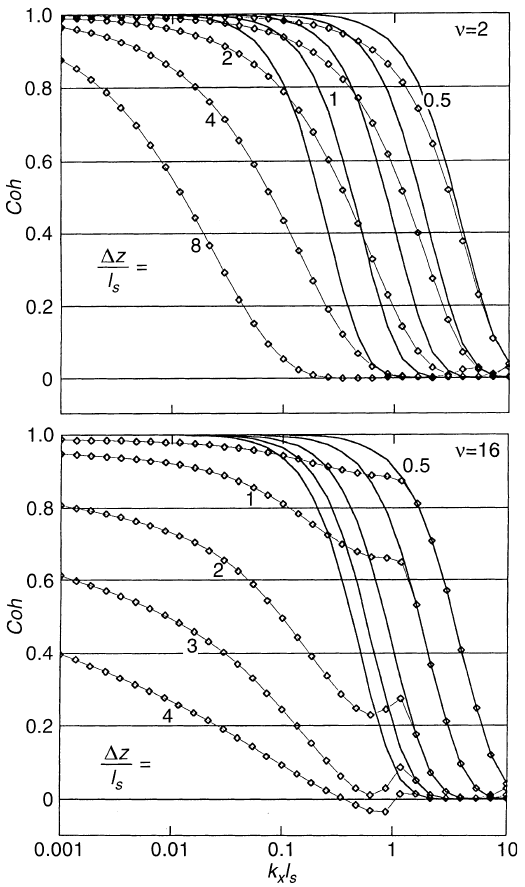
Fig. 6. The coherency spectra Coh (cid:133) k x ; (cid:68) z ; (cid:112) = 2 (cid:134) for E (cid:133) q (cid:134) (cid:136) q (cid:255) 3 and (cid:103) (cid:136) 1 (cid:135) (cid:133) ql s (cid:134) (cid:255) (cid:109) : (cid:109) (cid:136) 2 ( top, diamonds ), (cid:109) (cid:136) 16 ( bottom, diamonds ) and for LI inhomogeneities ( thick solid lines ); the numbers in the plots are the values of (cid:68) z = l